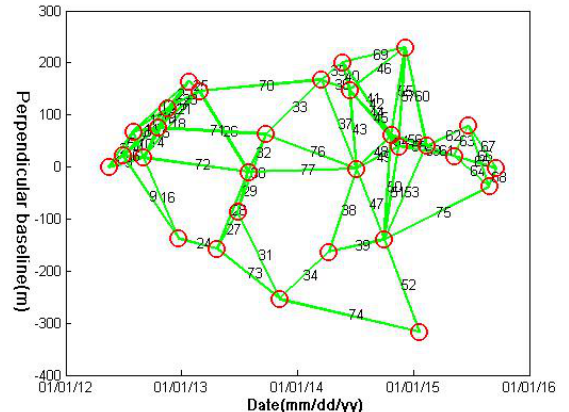
Figure 2. Small baseline interferometric combination between the 29 SAR images